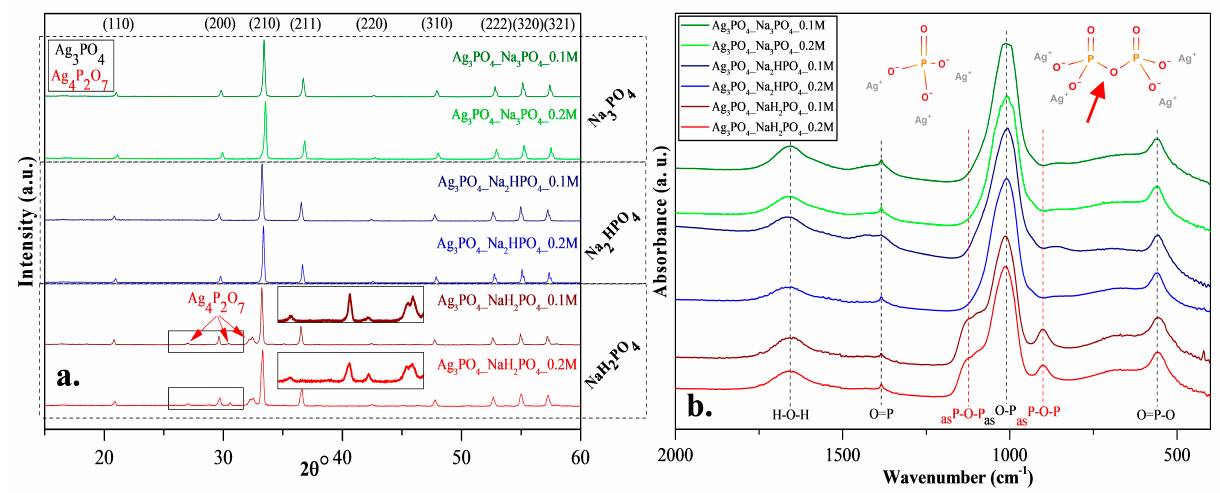
Figure 2. ( a ) X-ray diffraction patterns and ( b ) infrared spectra of Ag 3 PO 4 samples synthesized by using different types (Na 3 PO 4 , Na 2 HPO 4 and NaH 2 PO 4 ) and concentrations of phosphate sources (C = 0.1 and 0.2